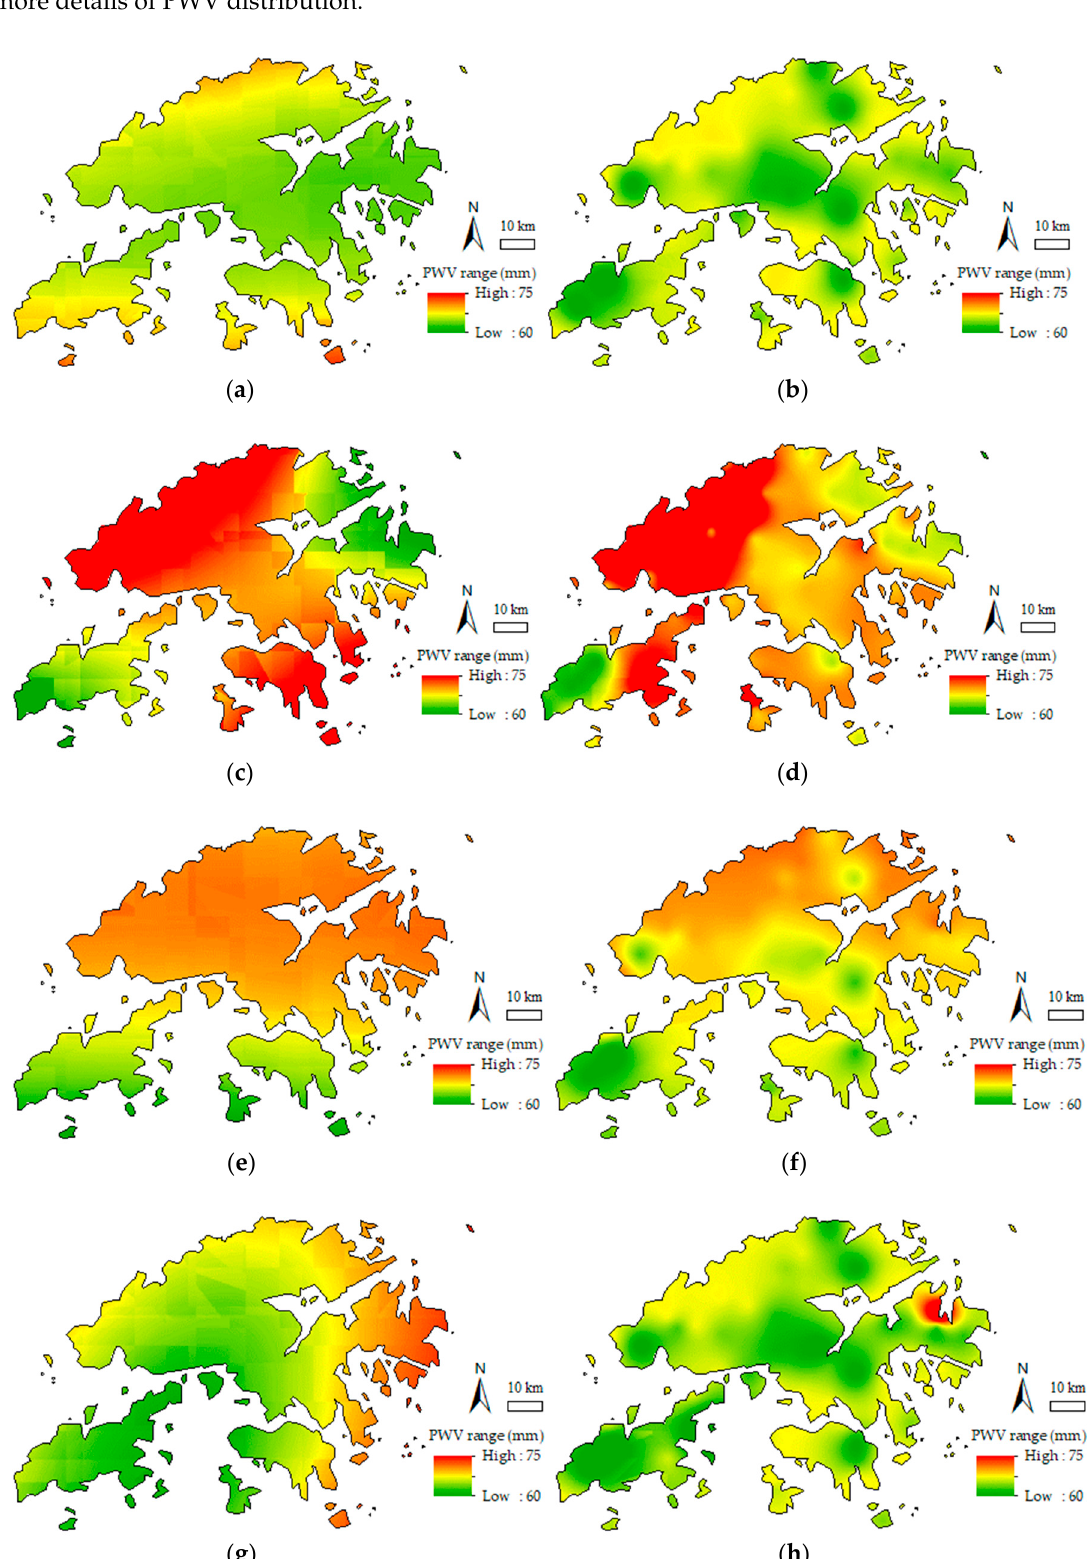
Figure 10. CK interpolation results for PWV provided by Schemes Ⅰ and II. Graph ( a,c,e ), and ( g ) are generated by Scheme Ⅰ , while graph ( b,d,f ), and ( h ) are generated by Scheme ⅠⅠ .